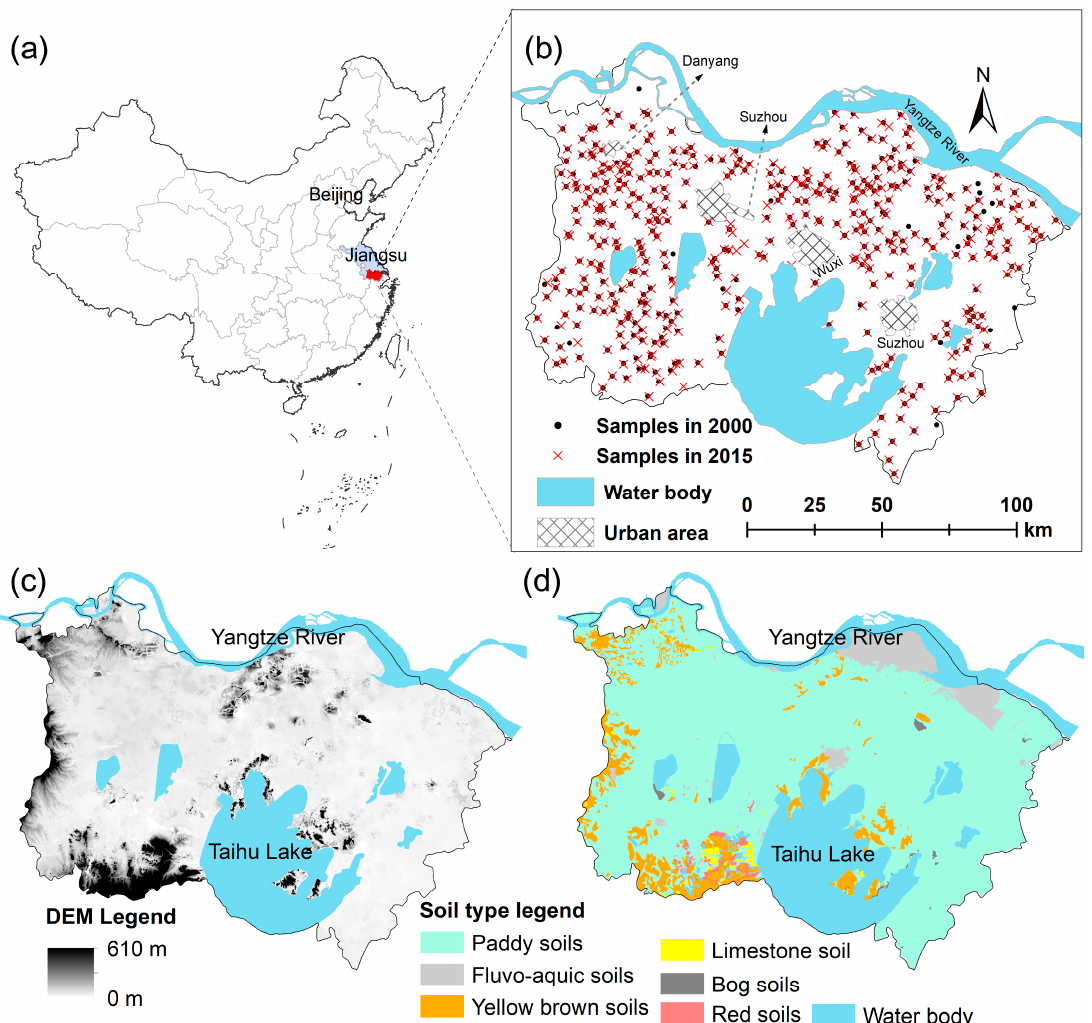
Figure 1. The location ( a ), soil sampling ( b ), topography ( c ), and soil distribution pattern ( d ) maps of the study area.